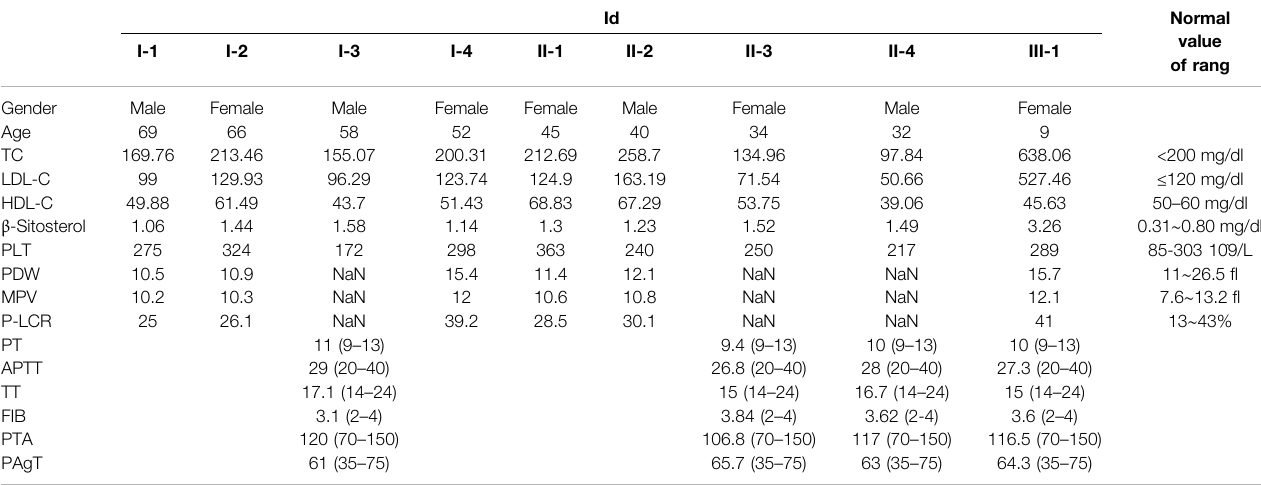
TABLE 1 | Clinical characteristics of the family members.